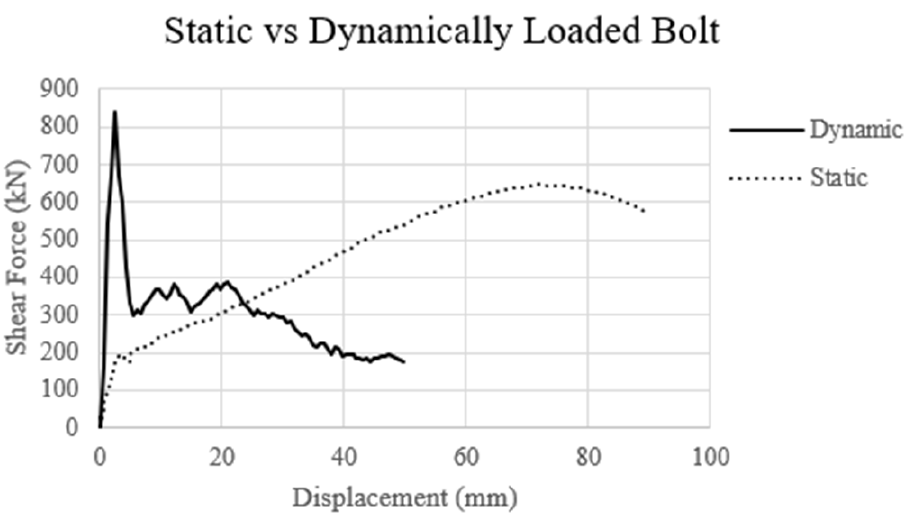
Figure 26. Static vs. dynamic load vs. displacement comparison.